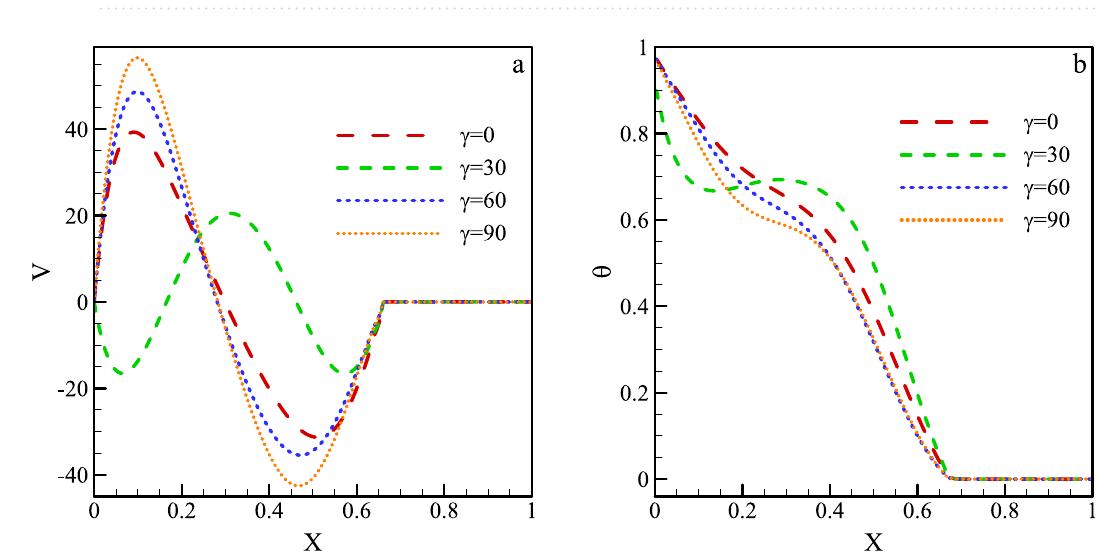
Figure 14. Temperature field for Ra = 10 5 , ω = 0, Ha = 20, Rd = 1 and various nanofluid concentrations and cavity angles.